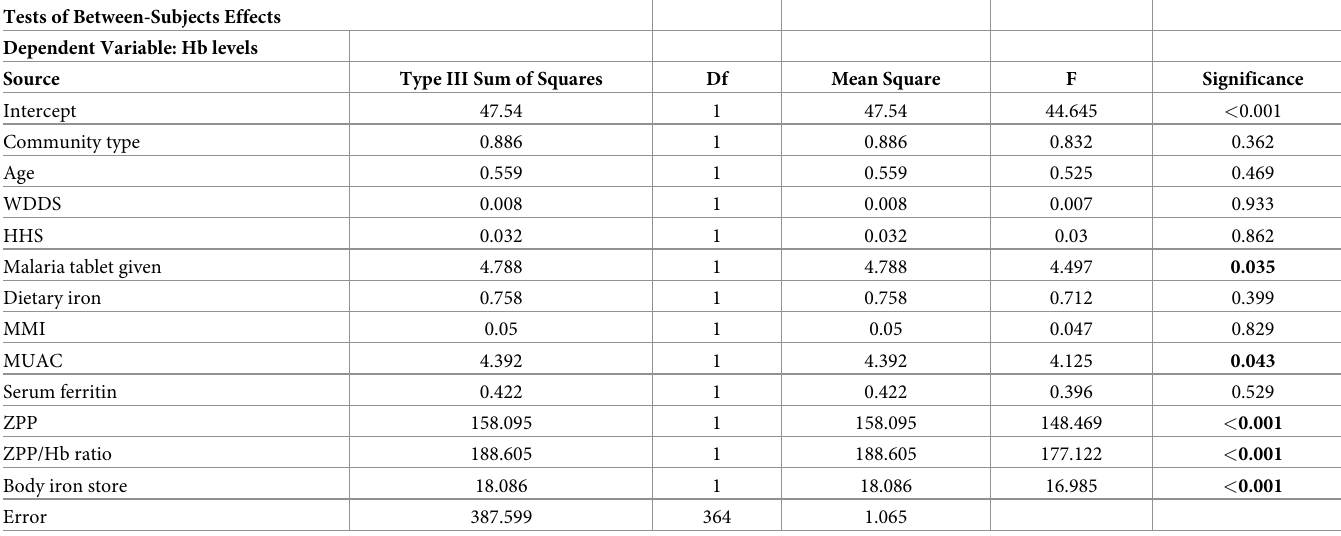
Table 4. Tests of between-subject effects of multiple variables on haemoglobin